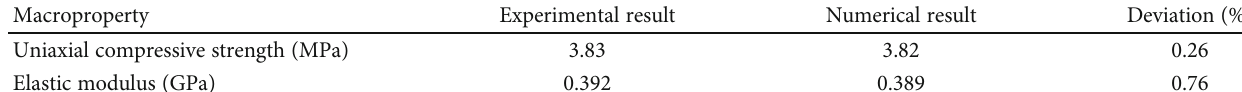
Table 2: Results of calibration of microparameter values of intact specimen.